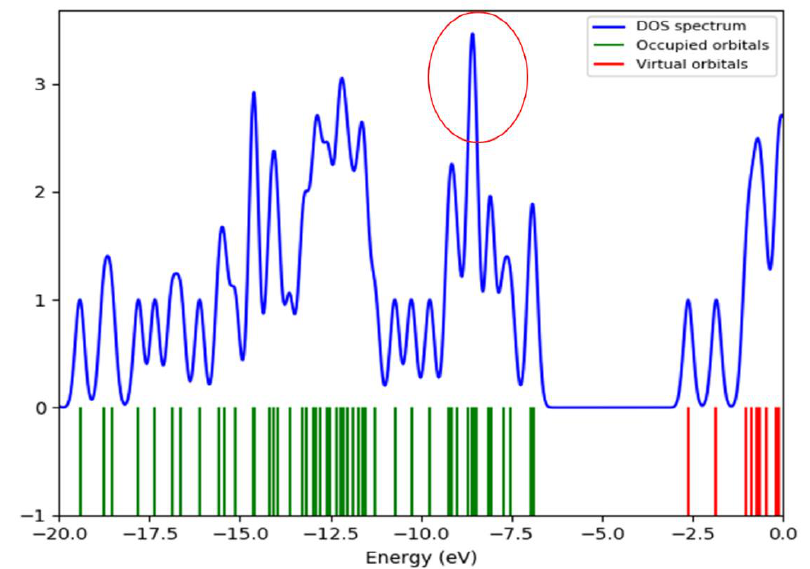
Figure 13. Molecular frontier orbital spectrum, their energies and TDOS were calculated at B3LYP/6- 311++G(d,p).